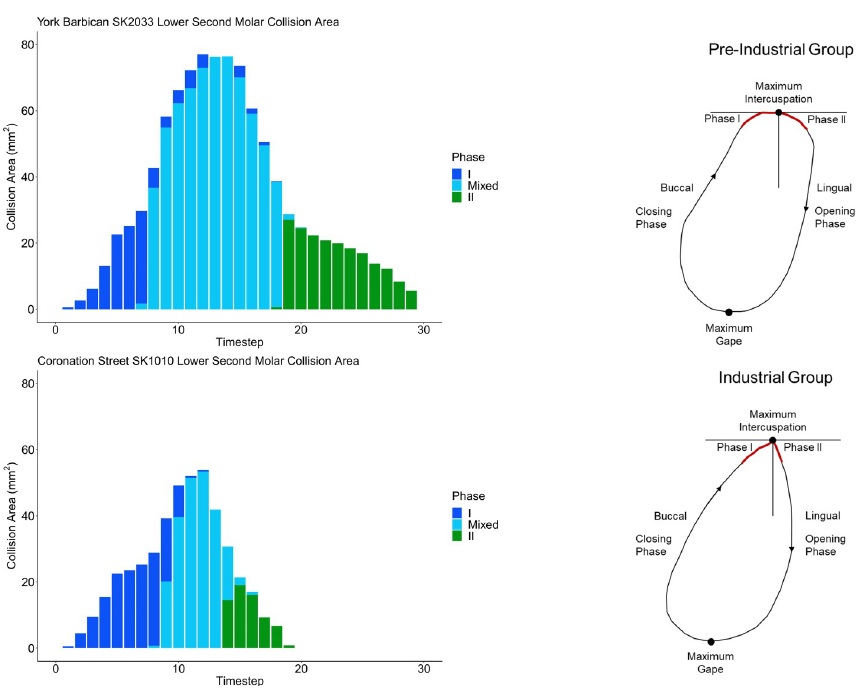
Fig 6. Development of contact areas during power stroke simulations and proposed chewing models. Left: Stacked bar charts comparing the development of wear facet areas for power stroke simulations conducted using the Occlusal Fingerprint Analyser software package. Each collision is broken down into a series of timesteps in which the lower tooth model attempted to move 0.05mm towards the next point along the estimated power stroke movement trajectory. The software calculates any collisions that occur between the opposing teeth at each time step. One individual was selected from the medieval period (SK2033 from York Barbican) and one individual from the industrial period (SK1010 from Coronation Street). The medieval individual showed an extended power stroke relative to the industrial individual and a more clearly defined and extended period of exclusively phase II contacts. Right: Visualisation of the hypothesized differences between the chewing cycles of individuals from the industrial and pre- industrial group.